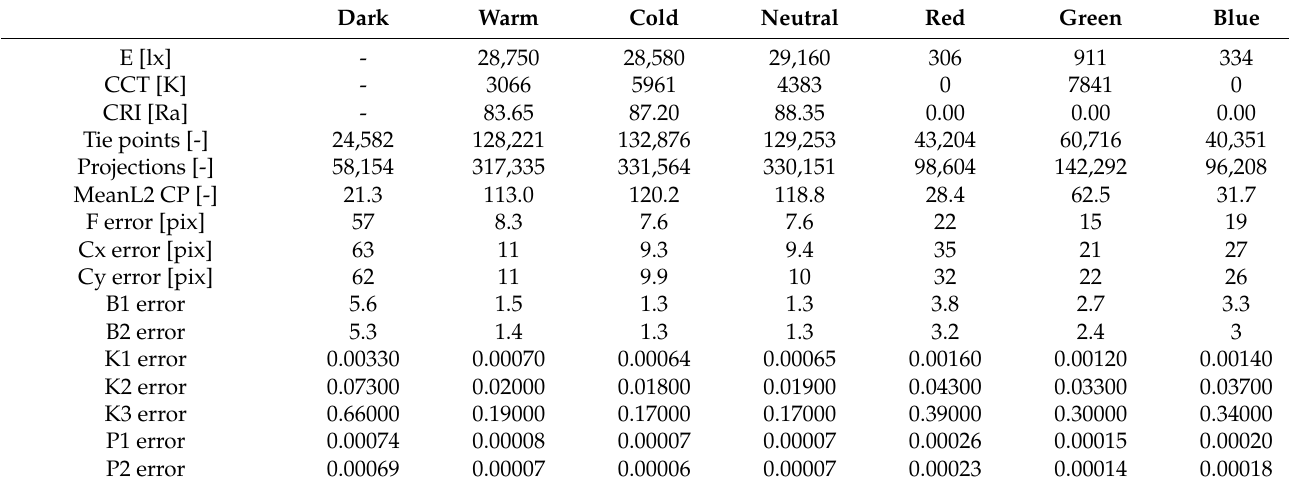
Table 6. Overall data characterising the LED light source, including the study’s geometric specification data. Dark Warm Cold Neutral Red